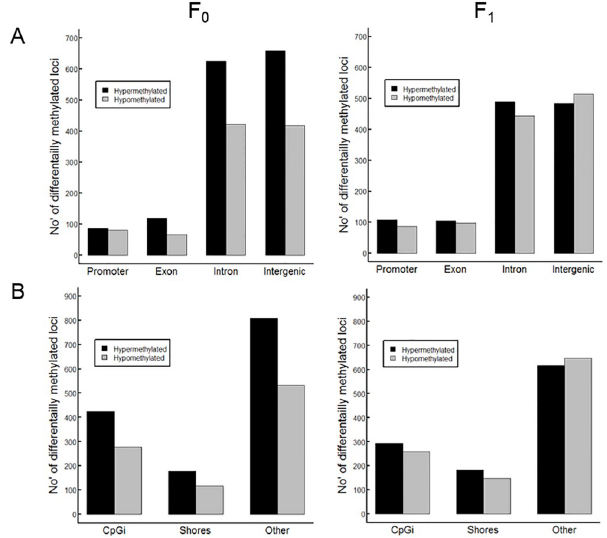
Fig 3. Differentially methylated loci across genomic regions in F 0 and F 1 livers. Differential methylation here shown as hyper- and hypomethylated loci across promoters, exons, introns and intergenic regions (A), CpG islands (CpGi) and shores